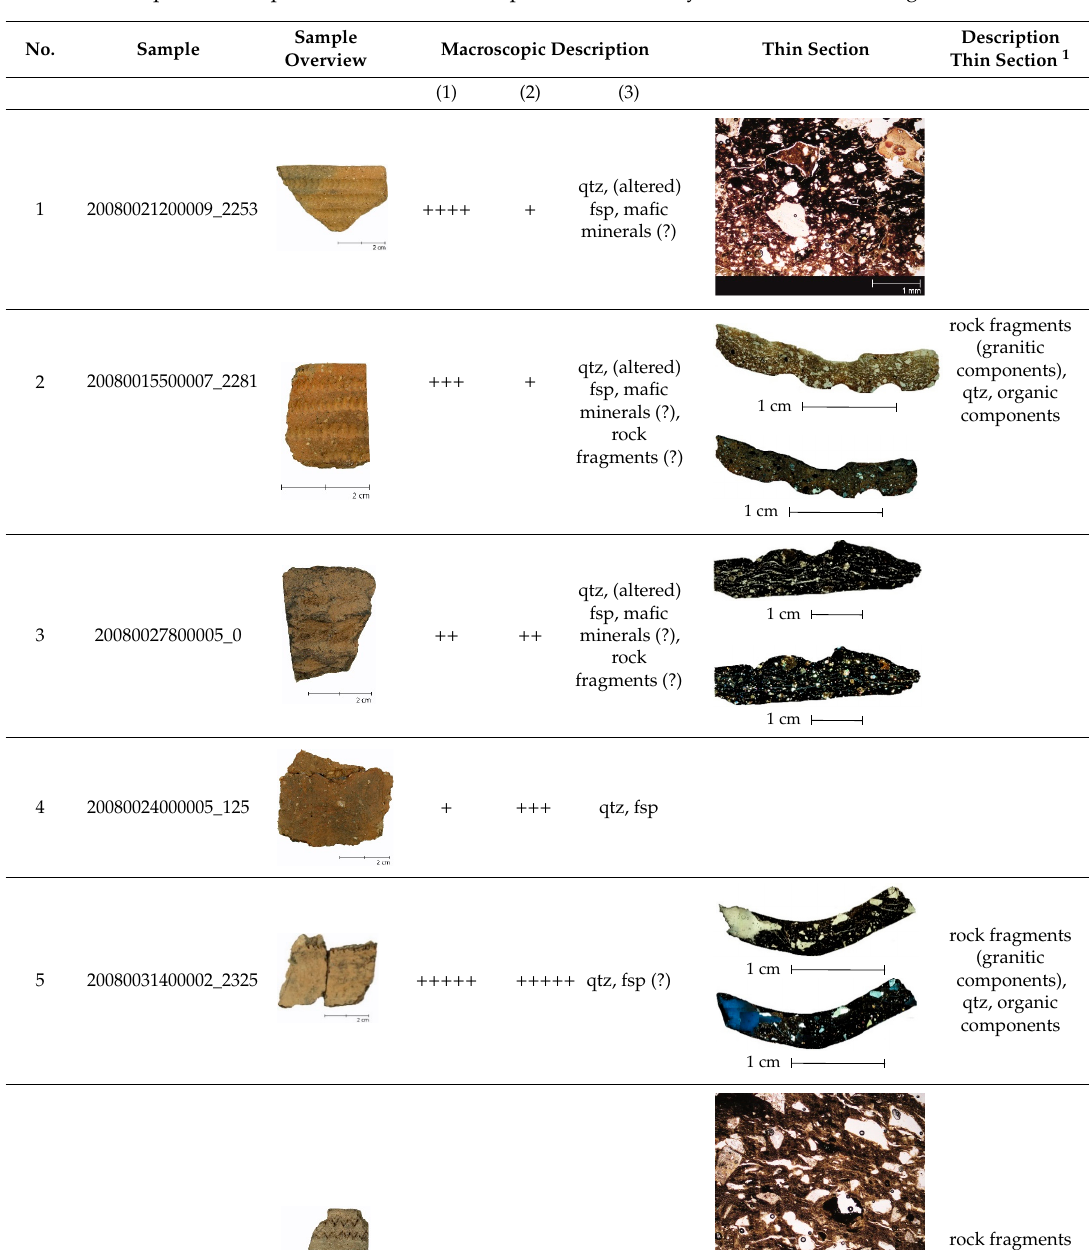
Table 4. Optical description of the ceramic samples from the study from the selected megalithic tombs.